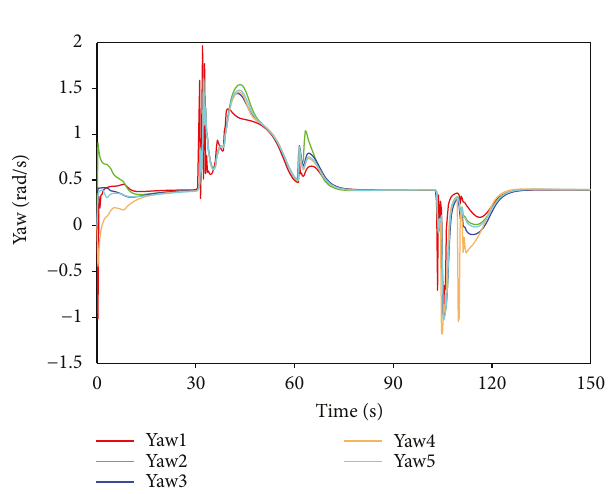
Figure 16: The relative distances.